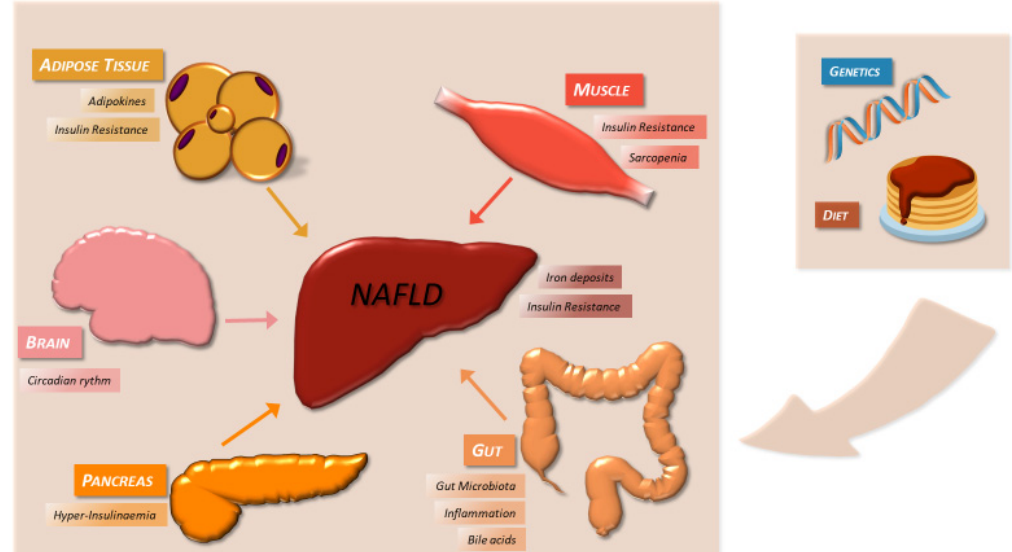
Figure 1. Multiple-hit pathogenesis of NAFLD [86,110,111]. Genetic factors cooperate with metabolic and environmental factors to promote the accumulation of fat in hepatocytes and successively cause inflammation, cellular death and fibrosis. Anatomically, besides the liver, the main factors are insulin sensitive organs such as adipose tissue and muscle, which respectively produce adipokines and myokines, and also promote inflammation and oxidative stress in the liver. The gut microbiota releasing PAMPs, the bile acid system and the presence of iron deposits contribute to liver damage. Finally, all these mechanisms are modulated by the brain, particularly by circadian rhythm.